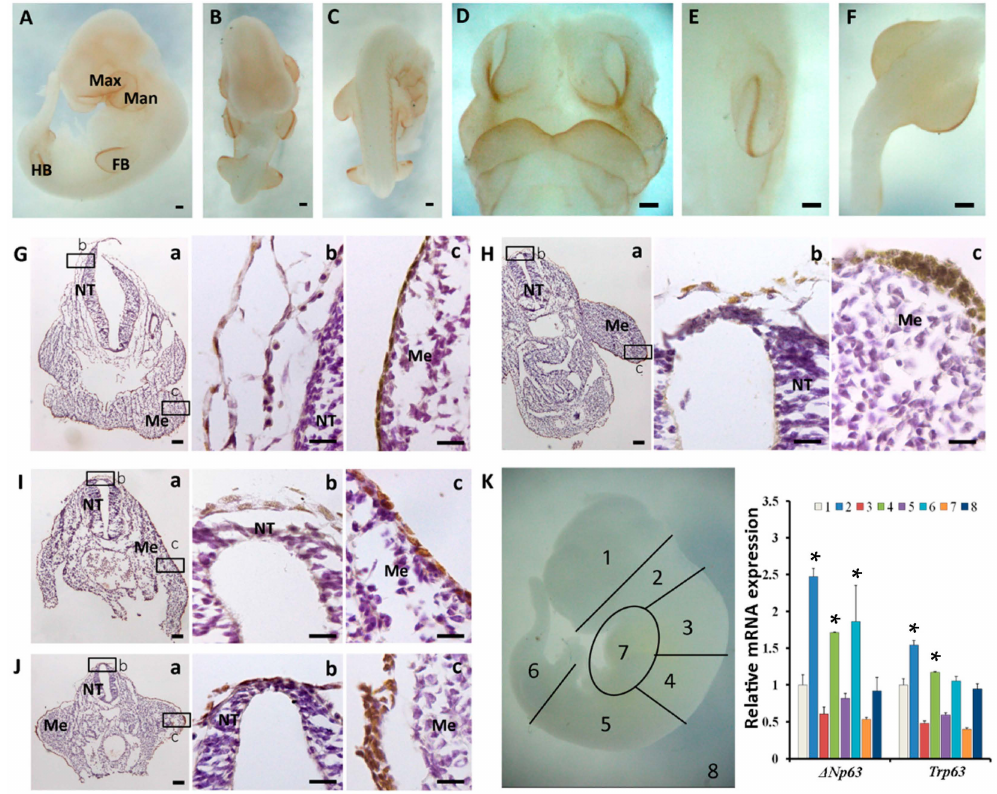
Figure 4. p63 expression in E10.5 embryos. ( A – C ) Different views showing the whole-mount immunostaining of p63 ( A ) lateral; ( B ) ventral; ( C ) dorsal view); ( D – F ) Images with higher magnification showing the head ( D ); the forelimb bud ( E ) and the hindlimb buds ( F ); ( G – J ) Transverse sections of the whole-mount-stained E10.5 embryo. b and c show the boxed areas in a, ( G ) head; ( H ) forelimb buds; ( I ) somite; ( J ) hindlimb buds; ( K ) qRT-PCR results showing relative ∆ Np63 and Trp63 mRNA expression in different regions of the E10.5 embryo. Note that the numbers in the right panel of K are corresponded to the numbers in the left panel of K . Max, maxillary; Man, mandibular; FB, forelimb bud; HB, hindlimb bud; NT, neural tube; Me, mesenchyme. Bar = 200 µ m for ( A – F ); bar = 100 µ m for Ga , Ha , Ia and Ga ; bar = 20 µ m for Gb , c , Hb , c , Ib , c and Jb , c . * p < 0.05 when compared with